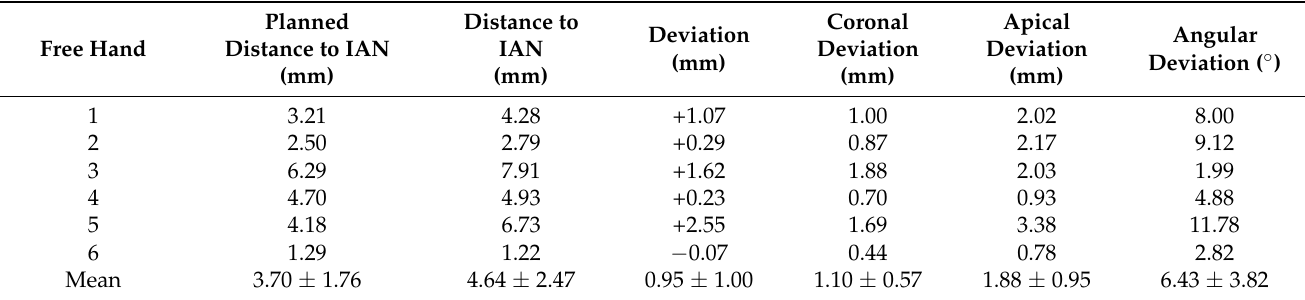
Table 2. Deviation from the planned position for freehand surgery. Positive values of deviation indicated a surgical position further away from the IAN, negative values of deviation indicate a surgical position closer to the IAN.